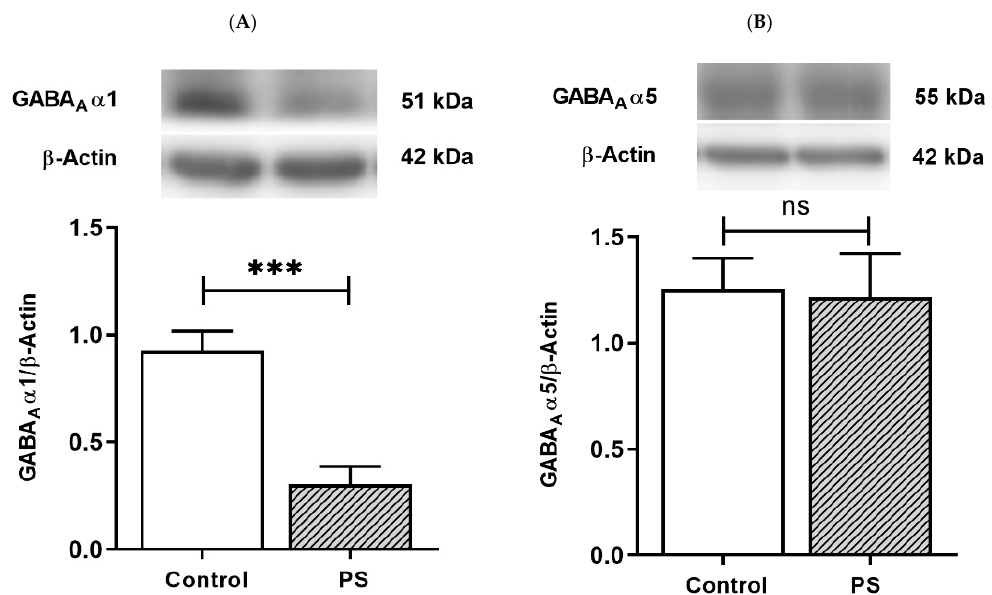
Figure 3. GABA type A receptors functional development. ( A ) Western blotting of GABA A receptor α 1 subunits. Upper, band comparing the control (left) and prenatal stress (PS) (right) groups; lower, bar graph displays the analysis of protein band densities of the GABA A receptor α 1/ß–actin ratio; the significant differences at *** p < 0.001. ( B ) Western blotting of the GABA A receptor α 5 subunits. Upper, band comparing the control (left) and PS (right) groups; lower, bar graph displays the analysis of protein band densities of the GABA A receptor α 5/ß–actin ratio; non-significance (ns) was found. Data are shown as the mean ± SEM, n = 5.